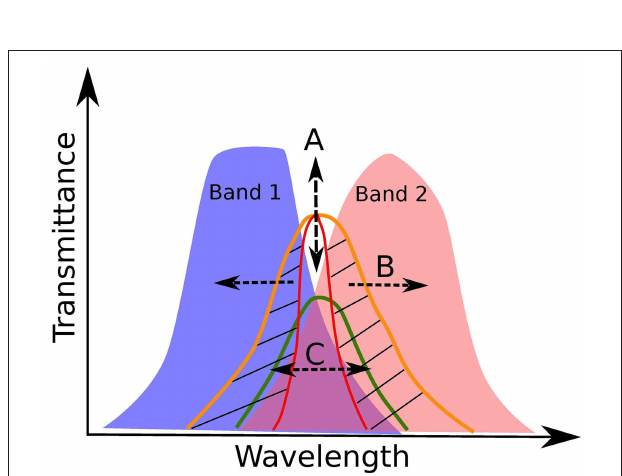
FIGURE 9 | A representative illustration for the quasar selection based on distribution of (A) line intensities; (B) band overlaps, and (C) line widths. Three instances of emission line profiles are shown in orange, red, and green, and the patched region highlights the importance of the broad distribution of equivalent widths (EWs) in quasars. The arrows mark the direction of the effect due to these three factors.